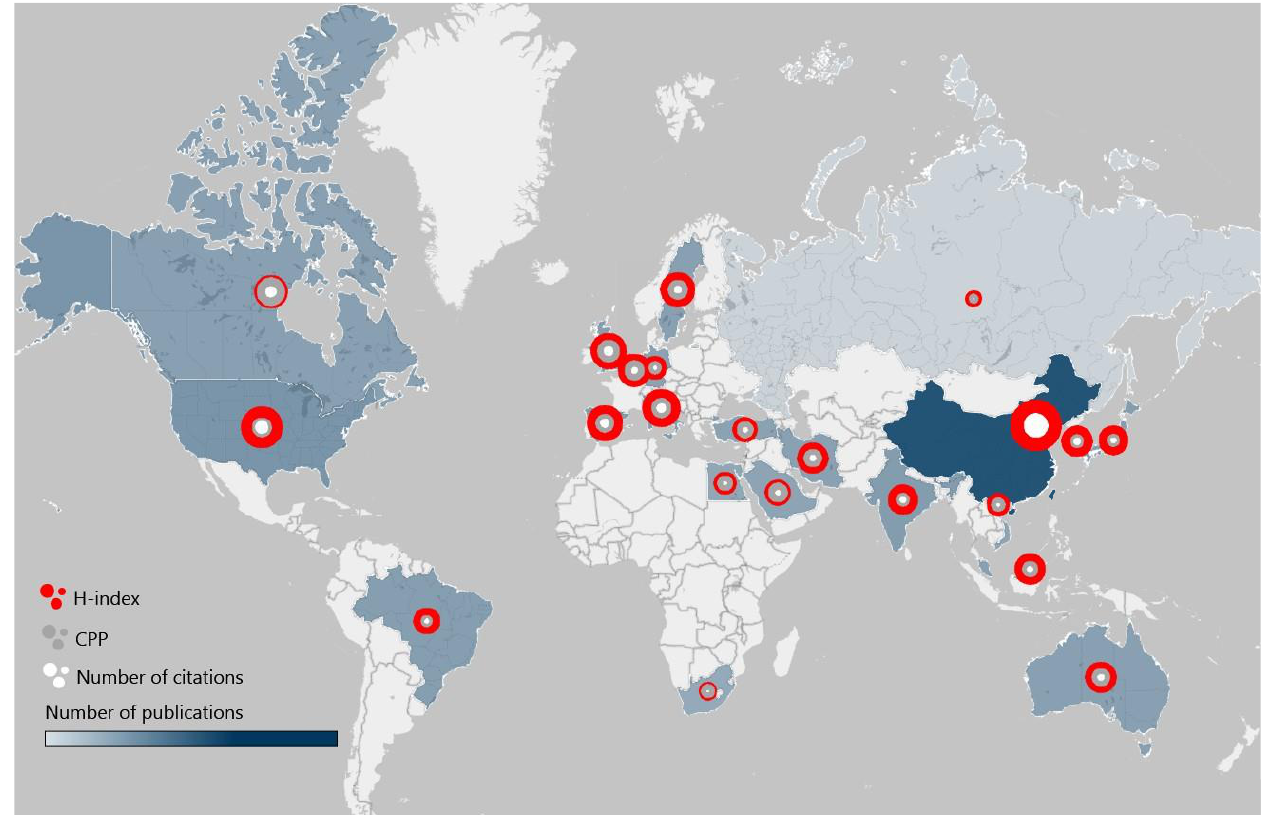
Figure 3. The regional distribution of H-index, CPP, number of citations, and publications.